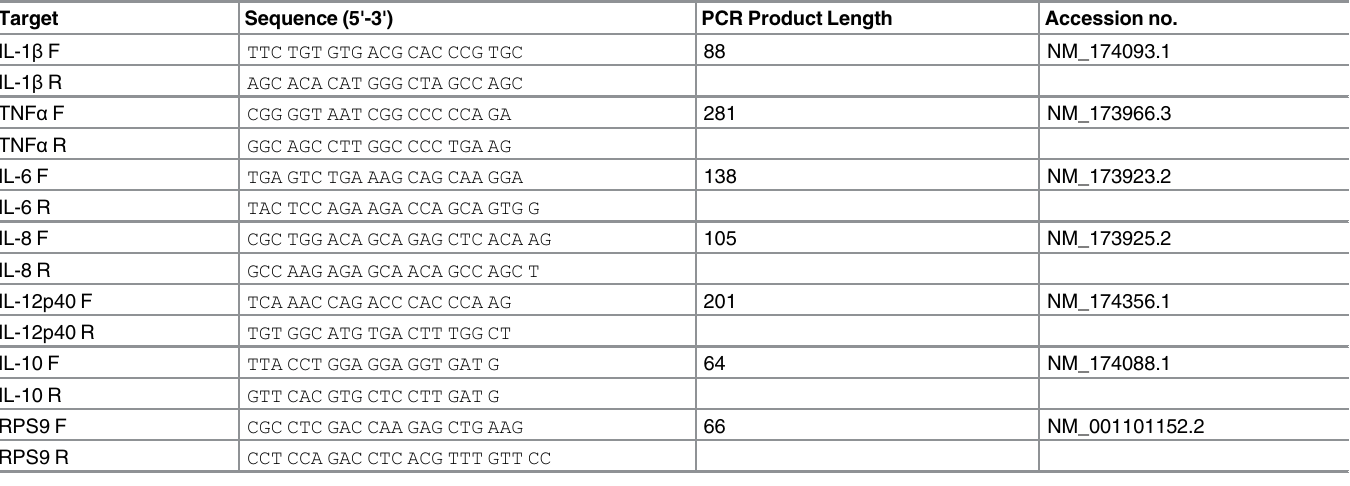
Table 1. Primer sequence for bovine targets and control genes.